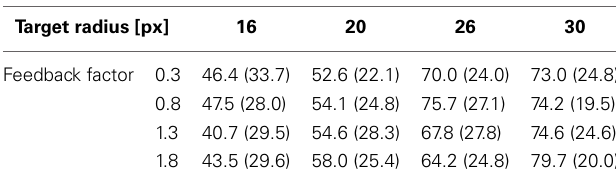
Table 7 | Mean hit rates [%] relating to the visible target surface in Experiment